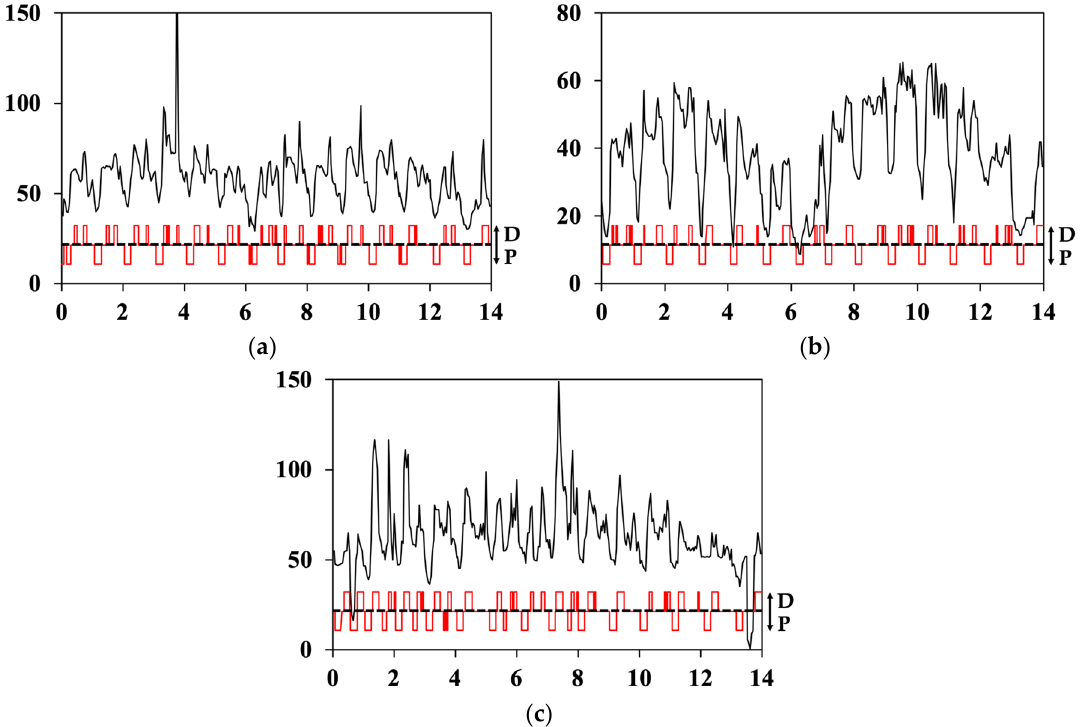
Figure 4. Fourteen-day electricity price curves (black line) and operation scenarios (red line) of three seasons: ( a ) winter, ( b ) spring-autumn, and ( c ) summer. Letters D and P refer to discharge and pumping phases.